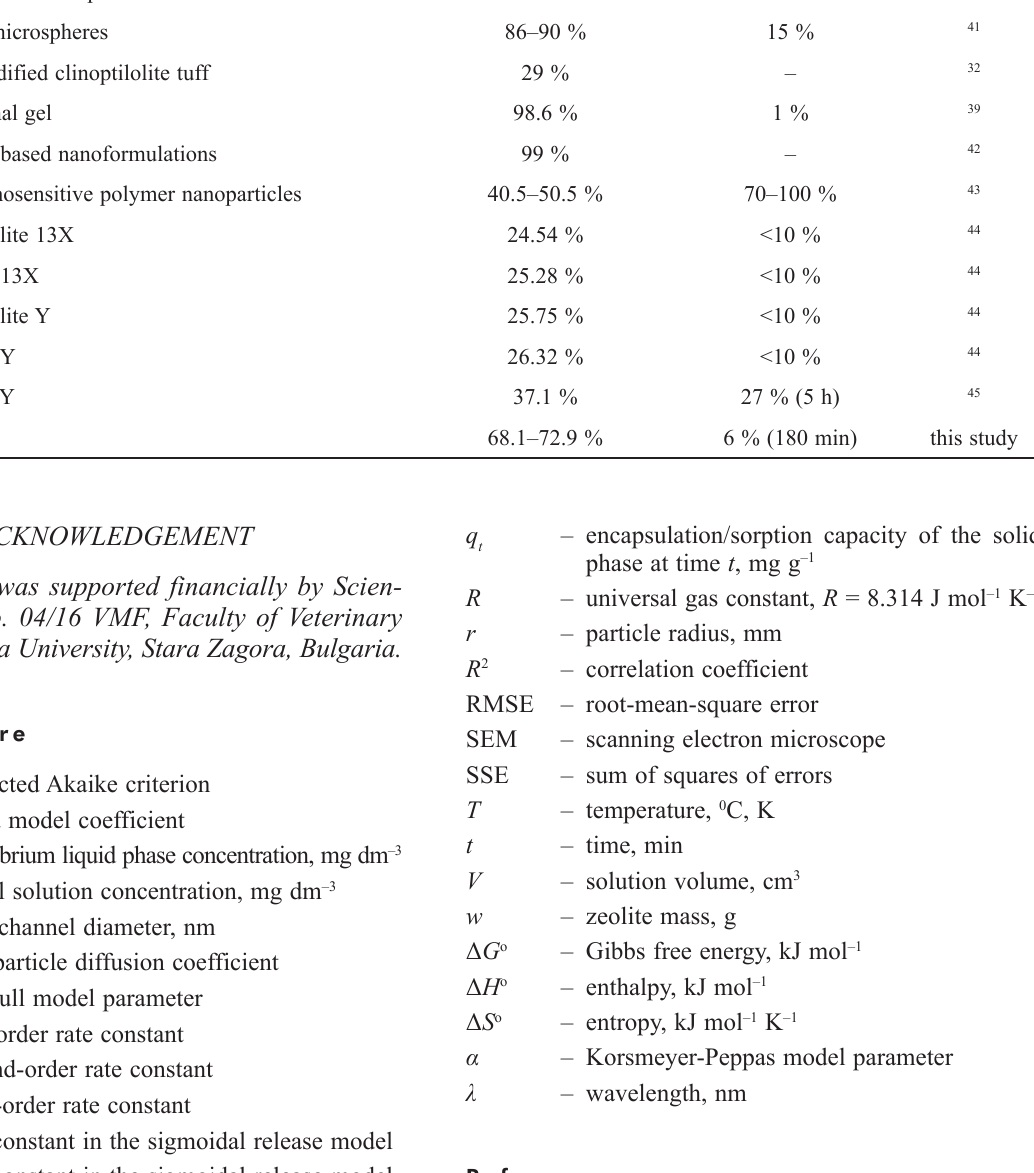
Table 7 – Literature review on vitamin E carrier and drug-zeolite composite systems Drug/carrier system Encapsul.